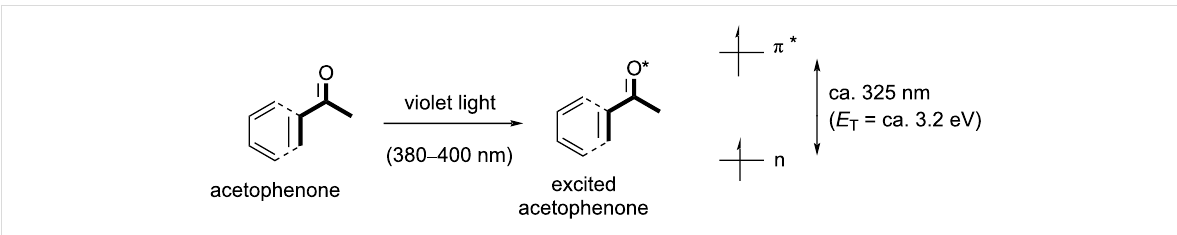
photoexcited by near-UV light (375–400 nm, Scheme 12). In the absence of a PSCat and using dedicated UV-light irradia- tion (275–375 nm), the product was observed together with nu- merous decomposition products (Scheme 13). No reaction was observed using a 19 W CFL bulb in the absence of a